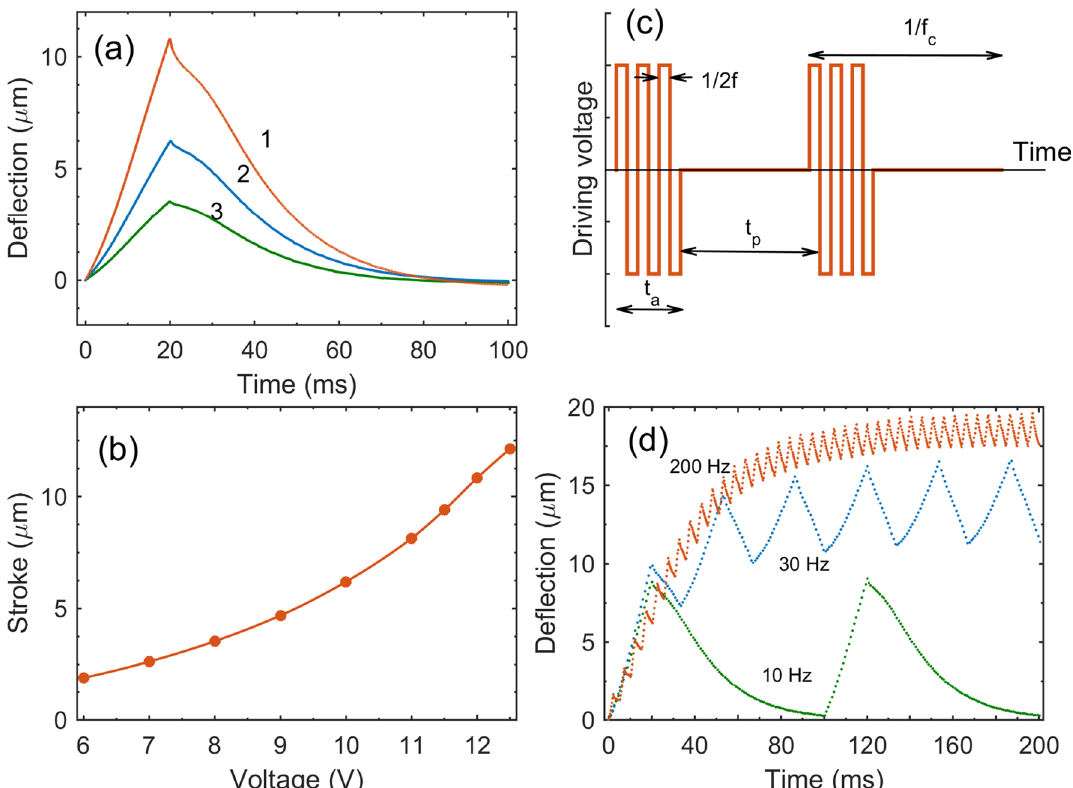
Figure 2. Characterization of the actuator at f = 500 kHz. ( a ) Deflection of the membrane by a 20 ms series of pulses. The graphs show one period of operation of the actuator at cyclic frequency f c = 10 Hz with the amplitude of the AP pulses 12 V (1), 10 V (2), and 8 V (3). ( b ) Maximum deflection of the membrane as a function of the amplitude of the driving pulses. ( c ) Scheme of the voltage powering the actuator in the cyclic operation regime. The important characteristics are shown. ( d ) Cyclic operation of the actuator for the frequencies f c = 10, 30, and 200 Hz. For 10 and 30 Hz the active time is 20 ms. For f c = 200 Hz the active time is 3 ms and the amplitude of pulses is U = 14.2